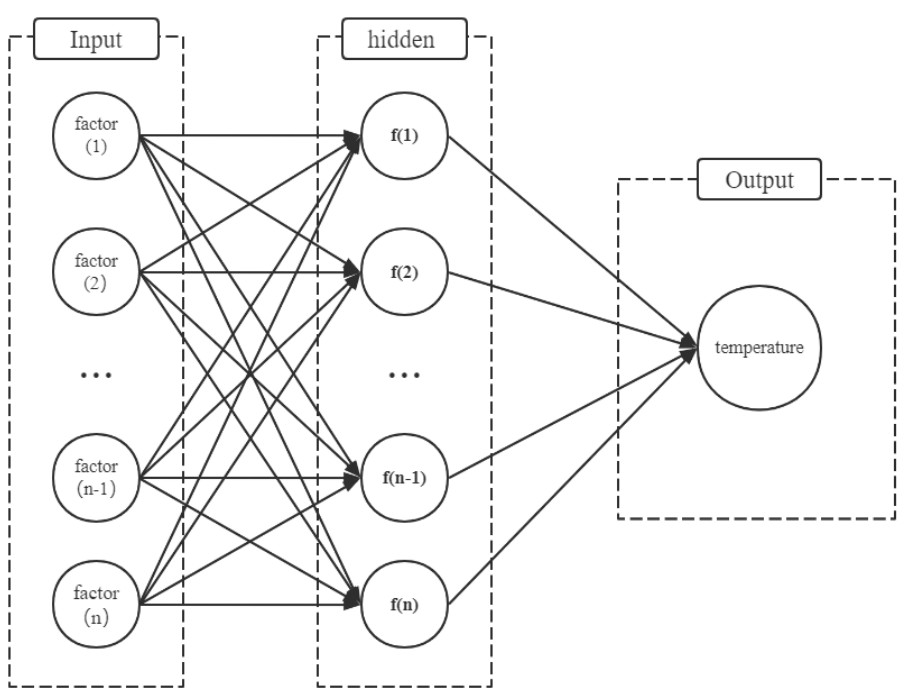
Figure 3. The multilayer architecture diagram of a typical neural network model.